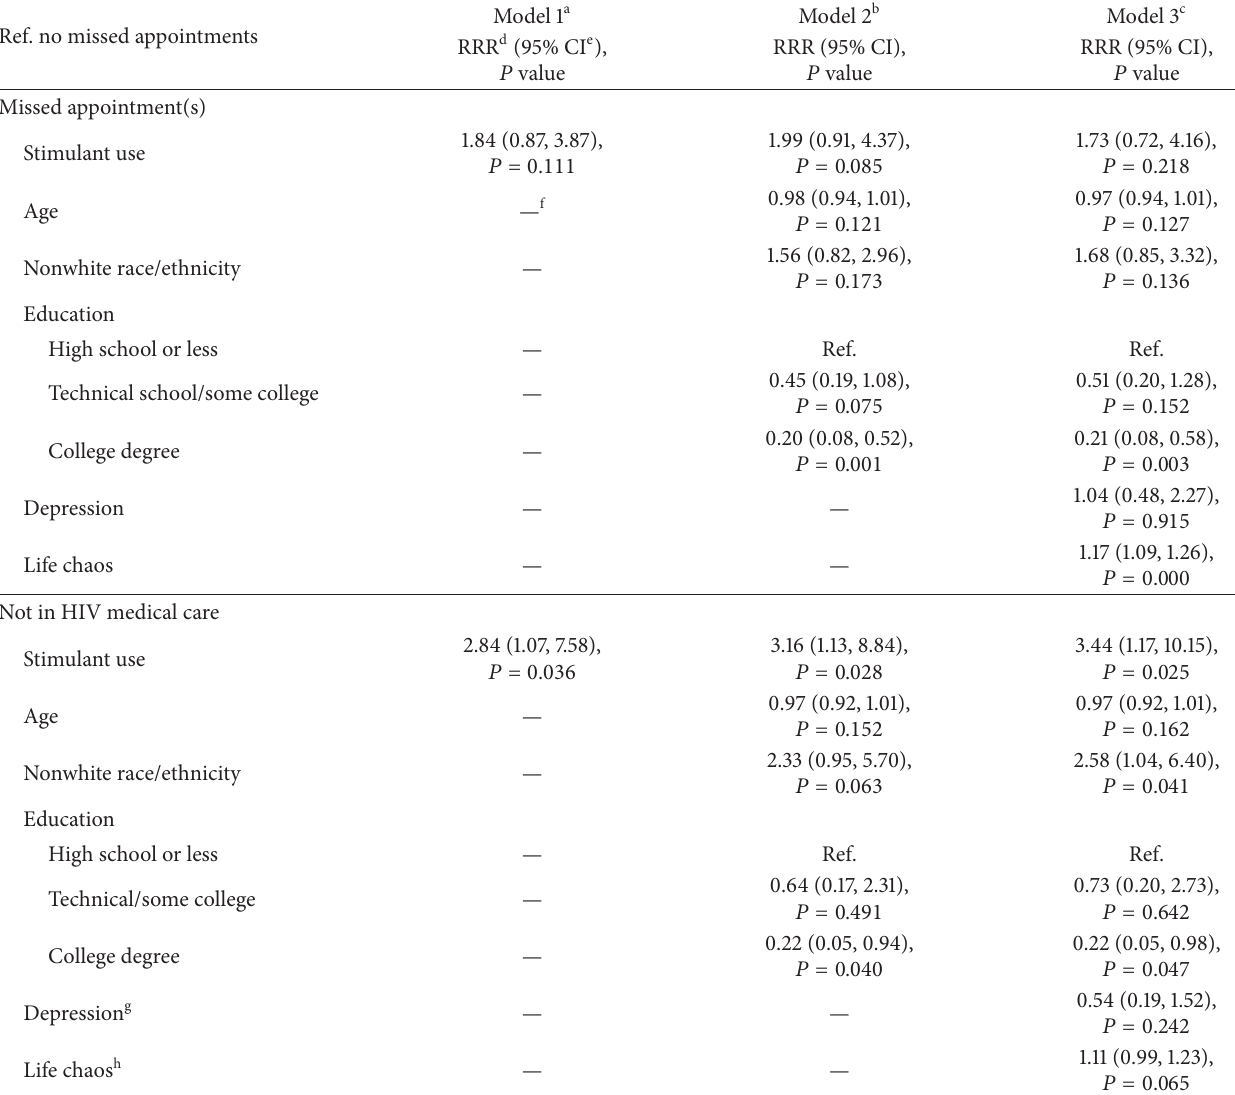
Table 3: Estimated effect of recent (past 30 days) stimulant use on engagement in HIV care in past